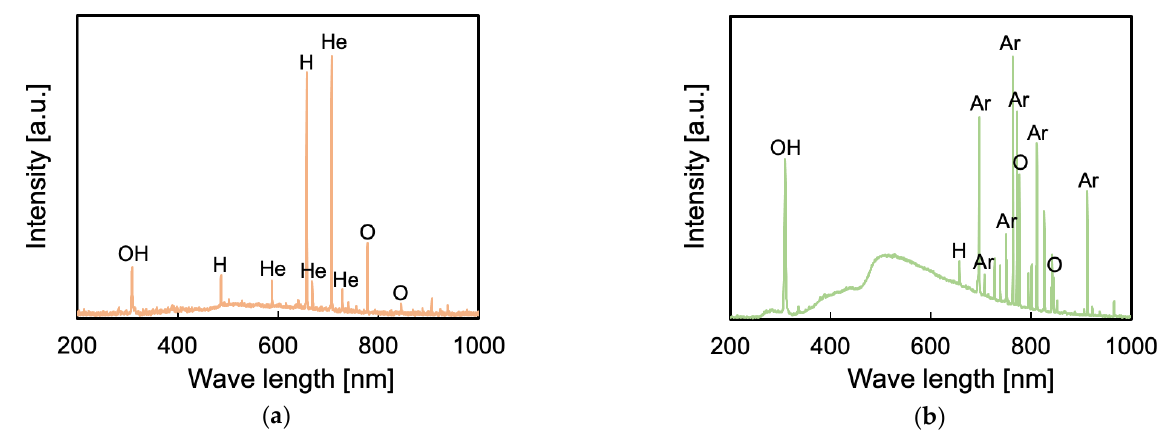
Figure 8. OES spectra in the plasma treatment without heating ( a ) using He gas and ( b ) using Ar gas. Each measurement period was 2 s.